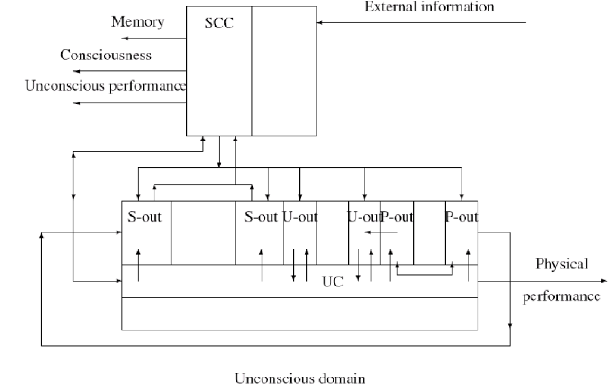
Figure 1. Model 1 of subconscious/unconscious functioning.